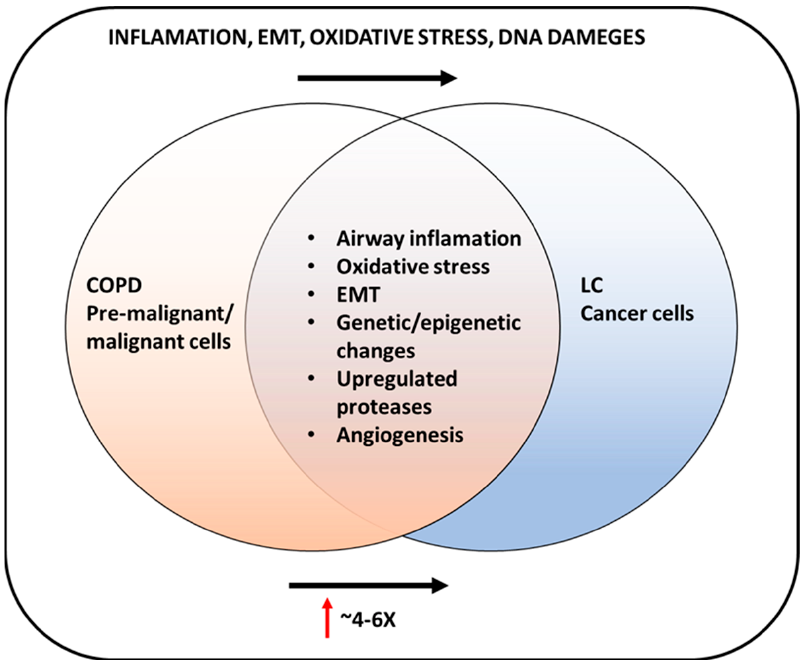
Figure 3. Increased lung cancer in chronic obstructive pulmonary disease (COPD). Inflammation and increased oxidative stress in COPD may enhance the growth and metastasis of lung cancer.